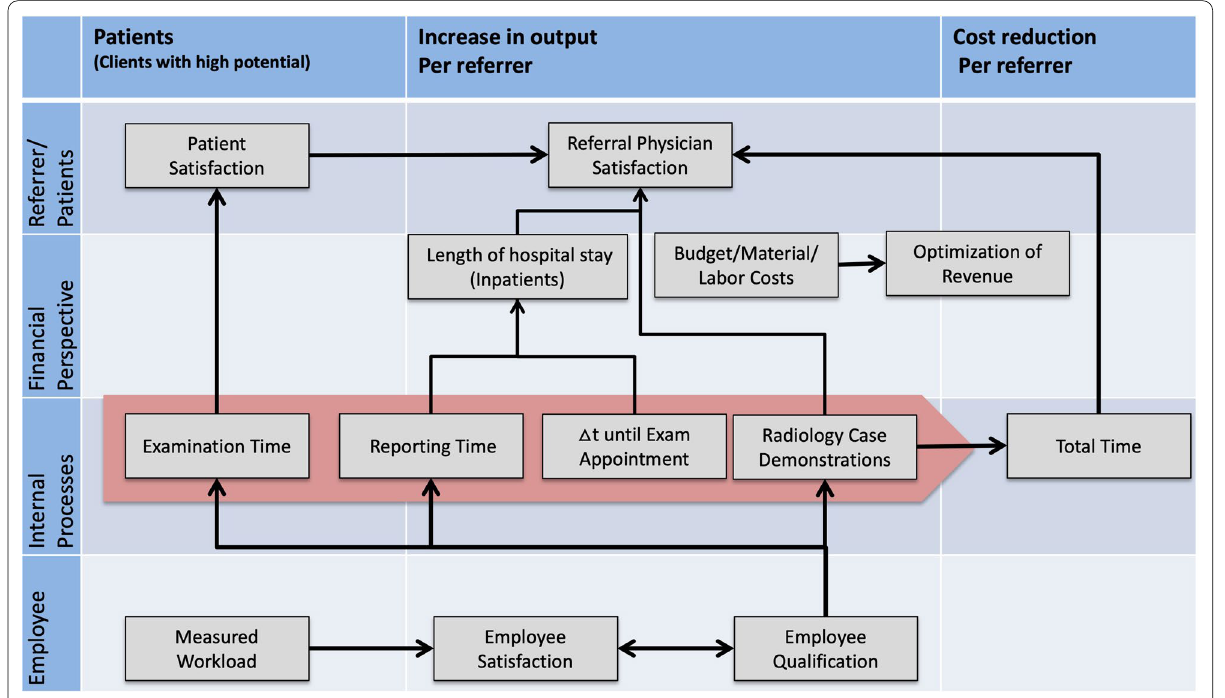
Fig. 3 Strategy map of the radiology